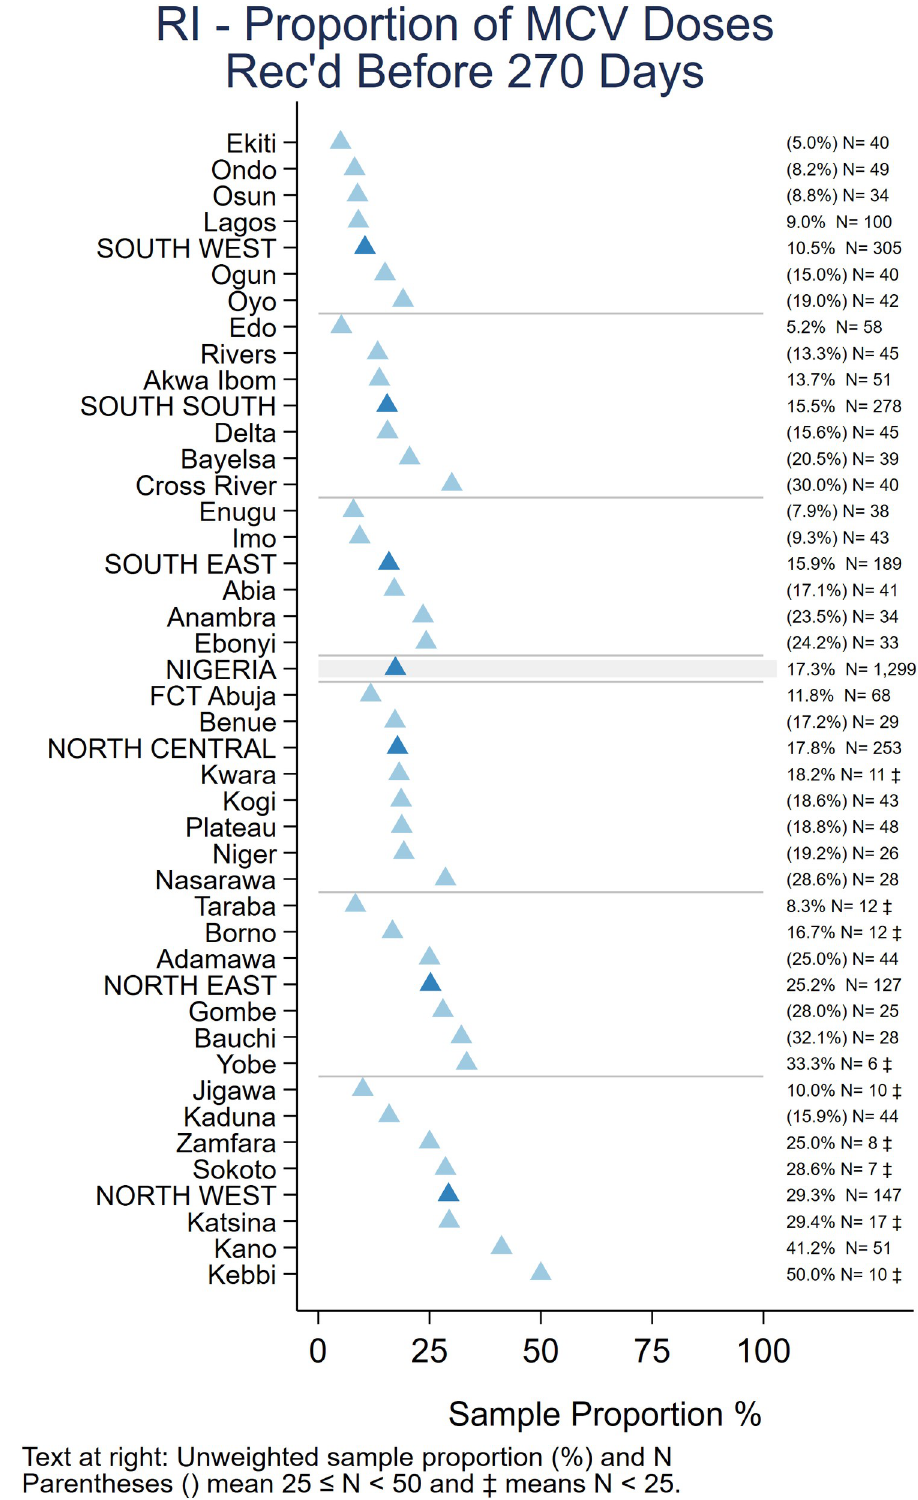
Fig 4. Unweighted percentage of children aged 12–23 months with a date of vaccination for MCV who received the vaccine before age 270 days, by state, Nigeria MICS/NICS 2016–17.